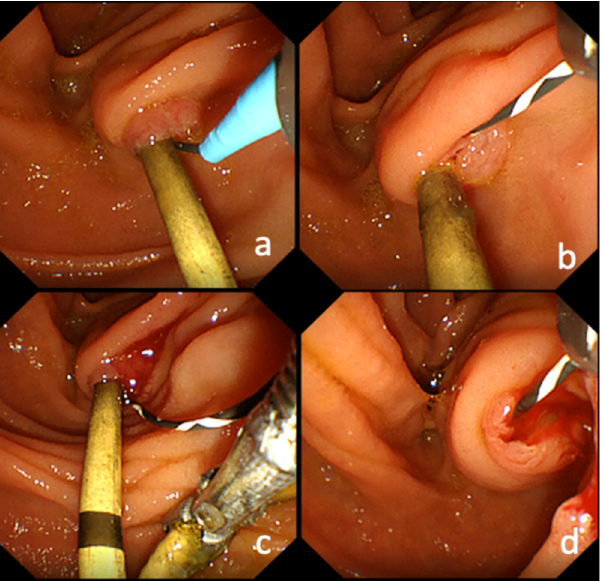
Figure 1. Endoscopic image of the side-of-stent method. ( a ). Biliary cannulation using a guidewire was performed from the side of the stent. ( b ). A guidewire on the side of the stent is visible. ( c ). Scratching through the guidewire and gripping the stent with gripping forceps. ( d ). The PS was removed with grasping forceps while leaving the guidewire.